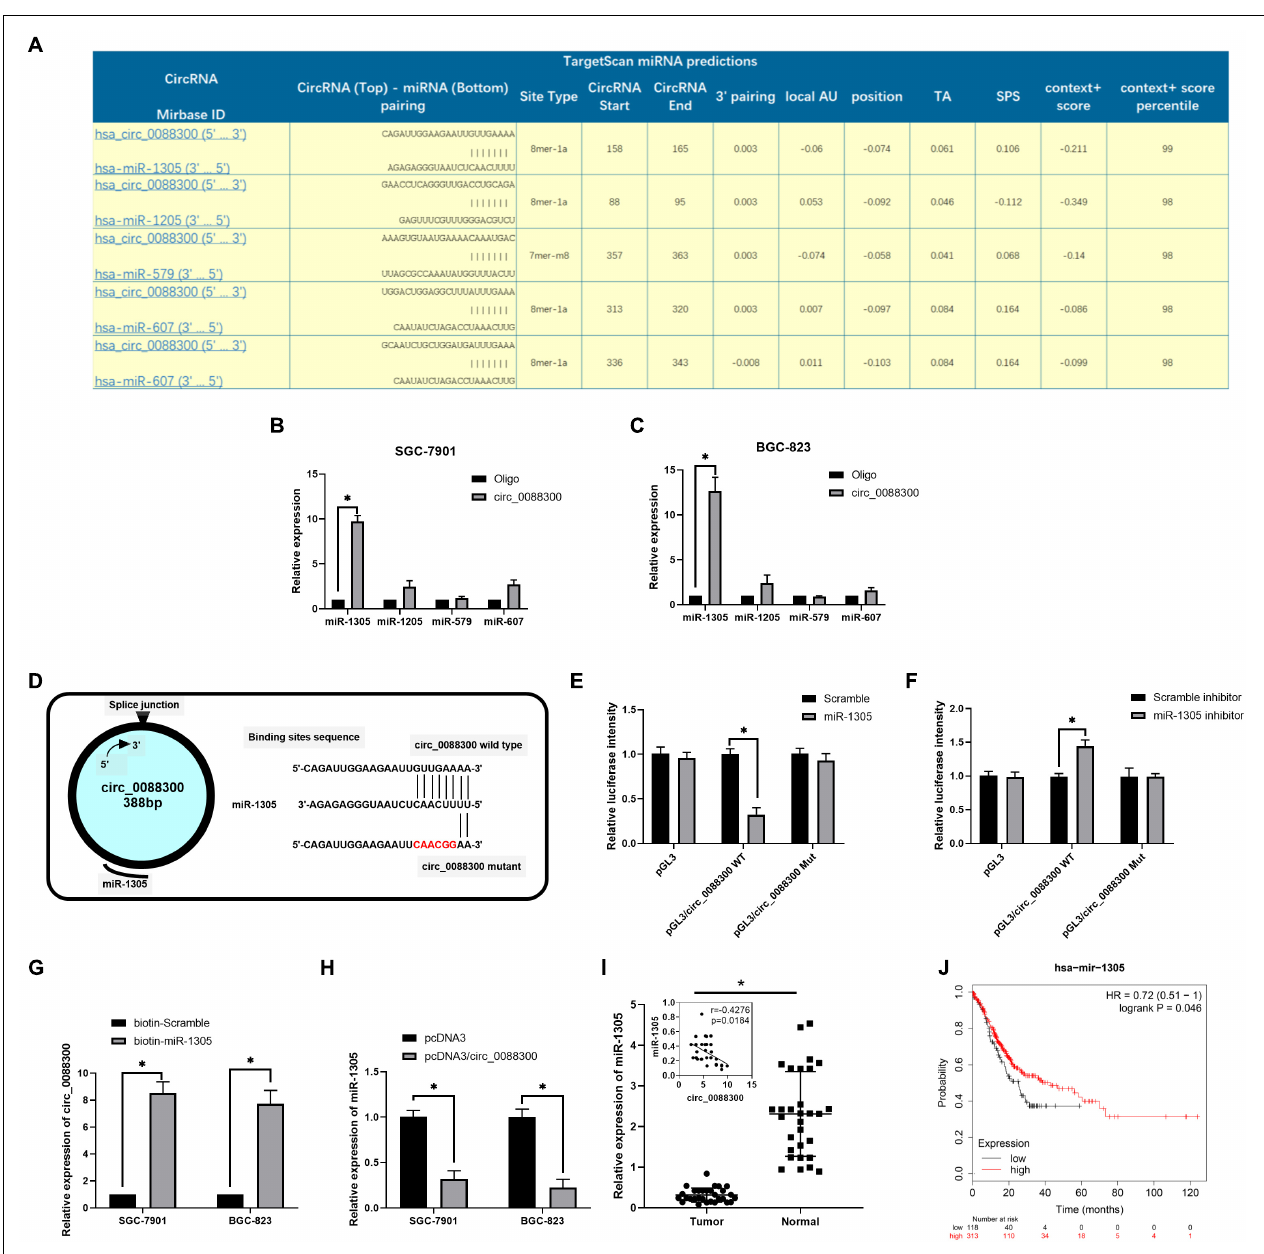
FIGURE 6 | Exosomal circ_0088300 acts as a sponge for miR-1305 in GC cells. (A) The top five miRNAs predicted to be downstream of circ_0088300 by the circular RNA interactome. (B,C) RNA RIP experiments were performed in GC cells using a circ_0088300 probe or a control probe. The enrichment of potential target miRNAs was detected by qRT-PCR and normalized relative to the control (one-way analysis of variance, Dunnett’s test). (D) The putative binding sites of miR-1305 in the wild-type (WT) or mutated circ_0088300 sequences. (E,F) A luciferase reporter assay was used to detect the relationship between circ_0088300 and miR-1305 in GC cells. (G) A pull-down assay was used to analyze the binding of circ_0088300 and miR-1305. (H) qRT-PCR of miR-1305 expression in SGC-7901 and BGC-823 cells transfected with pcDNA3/circ_0088300 or controls. (I) the expression of miR-1305 in 30 GC tissues and the correlation analysis between circ_0088300 and miR-1305 in 30 GC tissues. (J) Survival curve of GC patients with high expression of miR-1305 and low expression of miR-1305, as generated by KM Plot online ( ∗ P < 0.05).